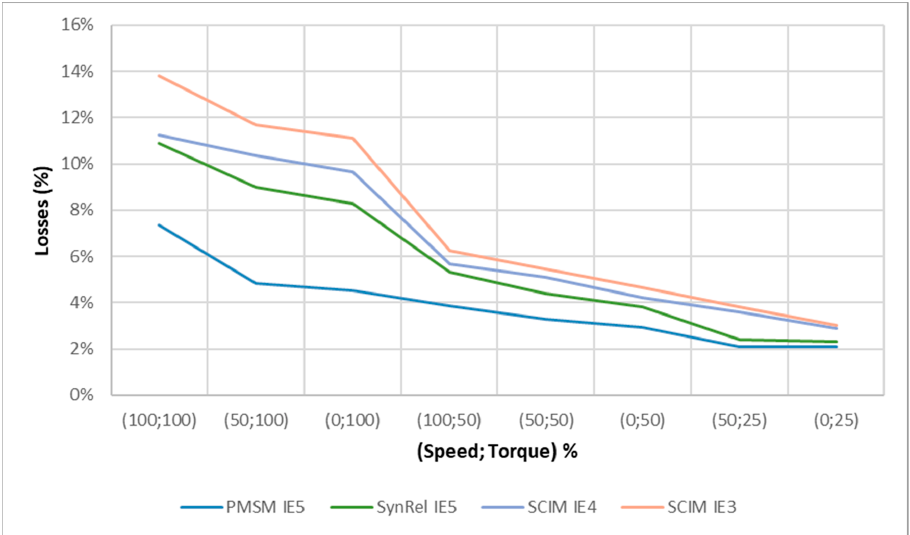
Figure 9. PDS losses as a percentage of the output rated power (7.5 kW).